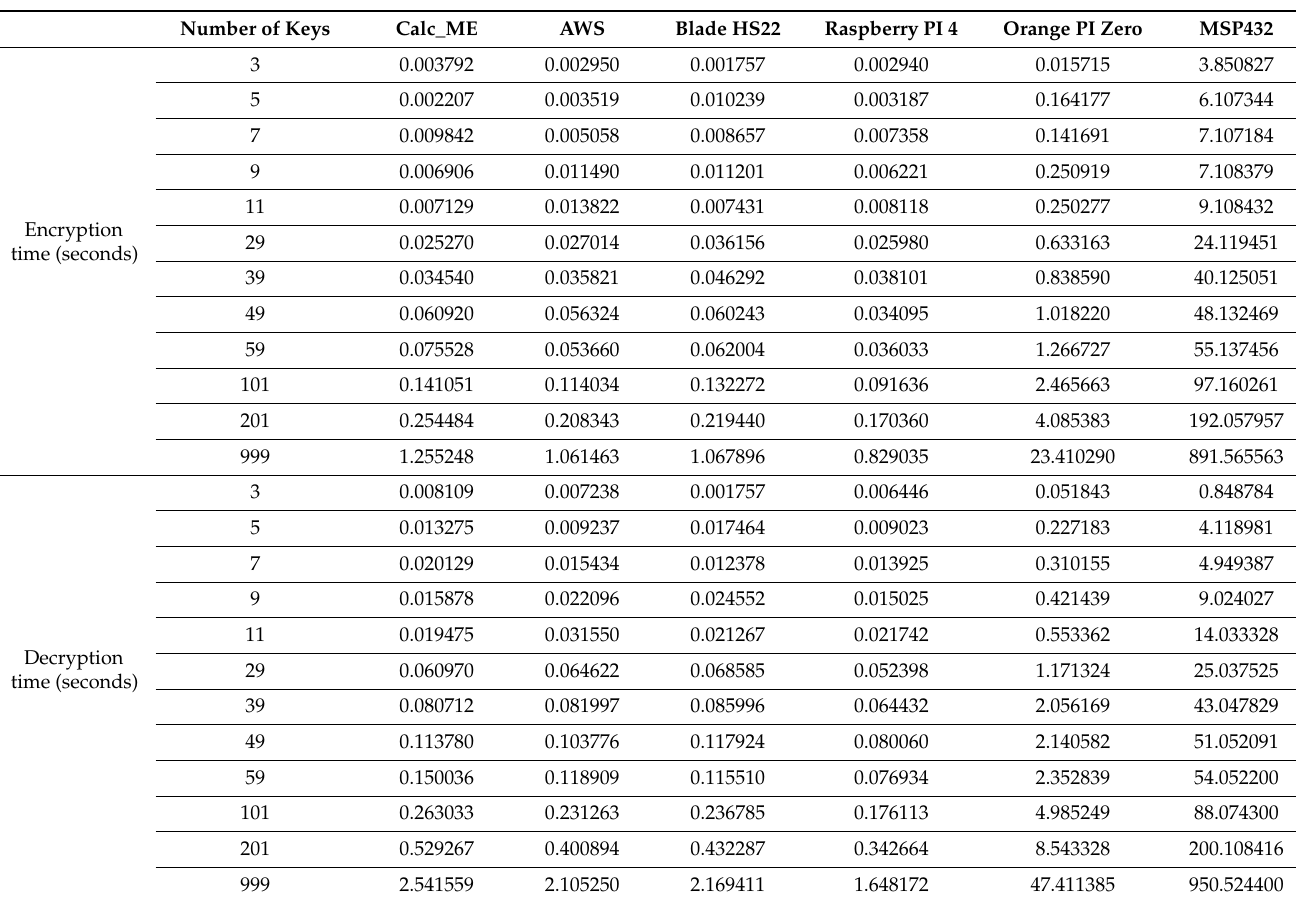
Table 2. Encryption/decryption elapsed times for using as a prime number p =